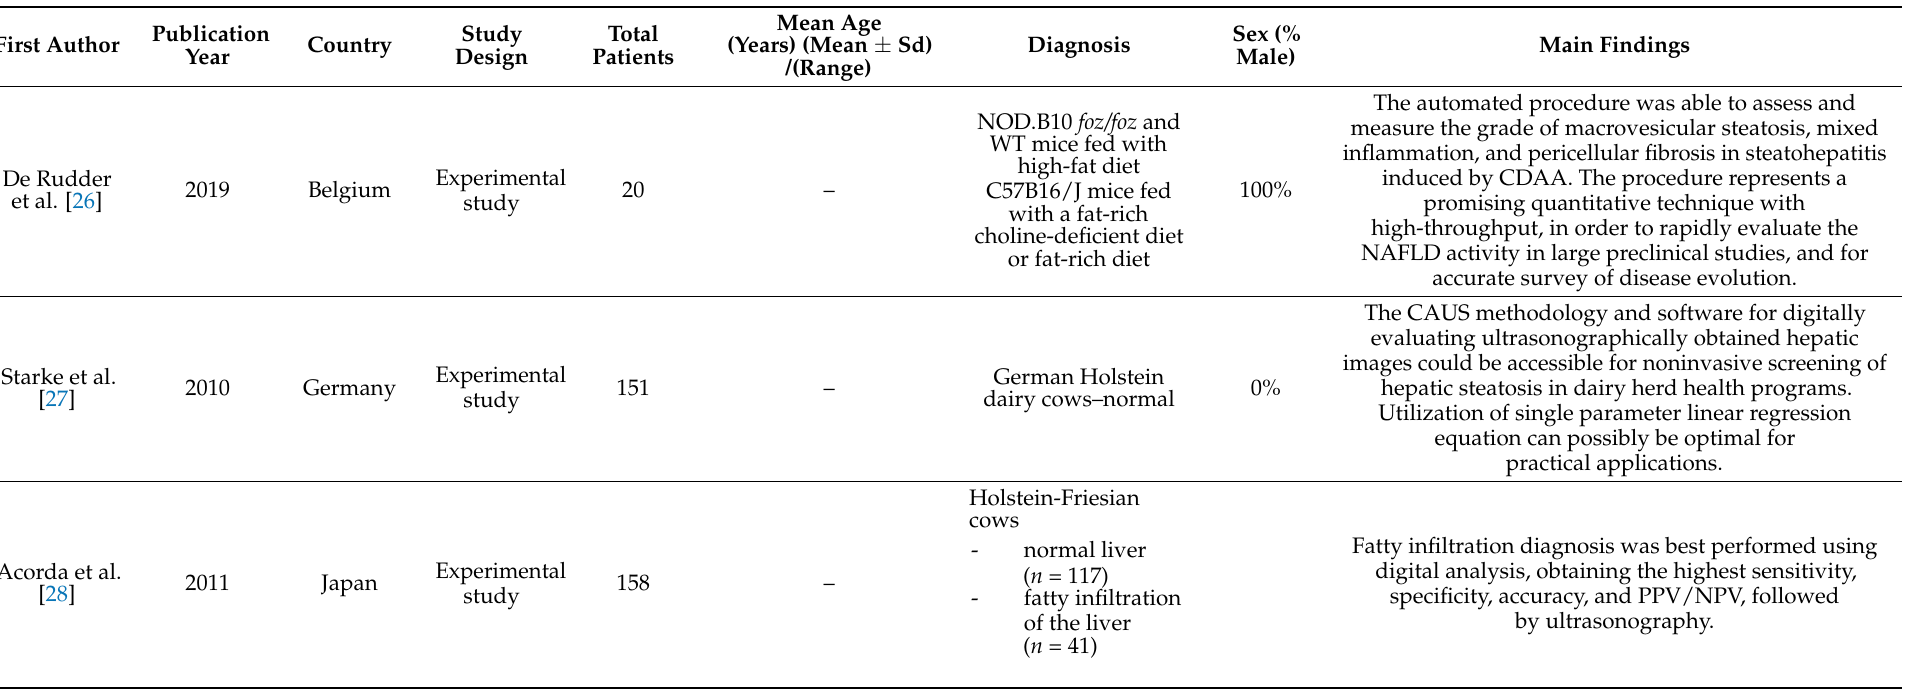
Table 2. Animal experimental studies Assessing Artificial Intelligence Based